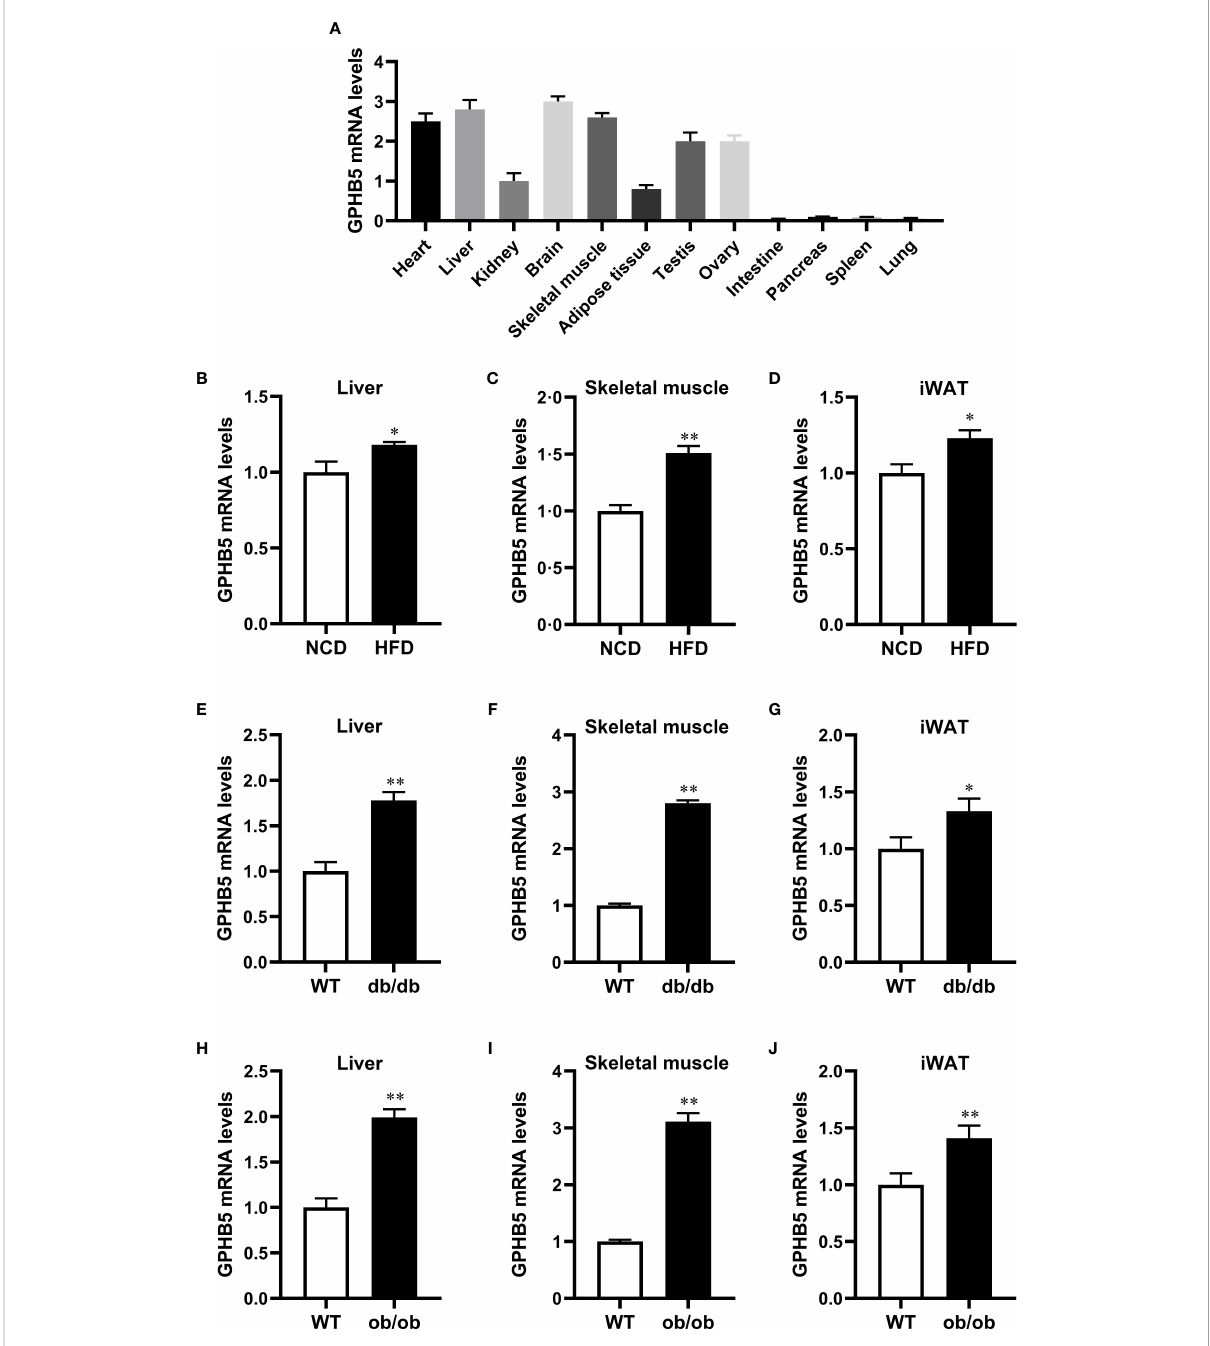
FIGURE 3 GPHB5 mRNA expression in mice. (A) GPHB5 mRNA expression in various tissues of mice. (B) GPHB5 mRNA expression in the liver of NCD- or HFD-fed mice. (C) GPHB5 mRNA expression in the skeletal muscle of NCD- or HFD-fed mice. (D) GPHB5 mRNA expression in the inguinal white adipose tissue (iWAT) of NCD- or HFD-fed mice. (E) GPHB5 mRNA expression in the liver of WT or db/db mice. (F) GPHB5 mRNA expression in the skeletal muscle of WT or db/db mice. (G) GPHB5 mRNA expression in the iWAT of db/db or mice. (H) GPHB5 mRNA expression in the liver of WT or ob/ob mice. (I) GPHB5 mRNA expression in the skeletal muscle of WT or ob/ob mice. (J) GPHB5 mRNA expression in the iWAT of WT or ob/ob mice. Data are means ± SD. * p < 0.05; ** p < 0.01 vs. NCD or